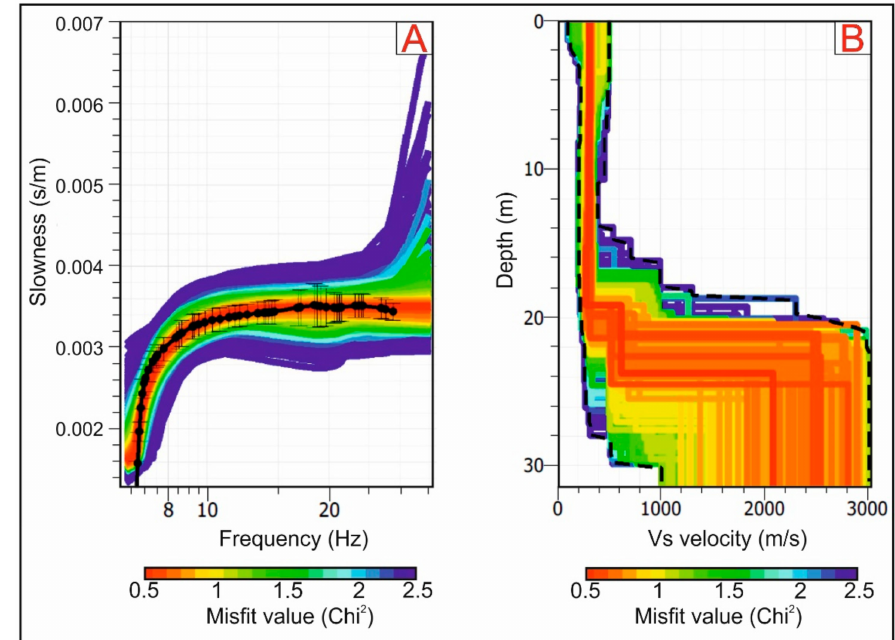
Figure 3. ( A ) The uncertainty of the dispersion curve modeling. The picked dispersion curve (black line) with the uncertainty of picking was well fitted to the synthetic models (colored areas). The chi-squared parameter for the best theoretical curves was less than one; ( B ) 1D result of the multi-channel analysis of surface waves (MASW) analysis for shot 164. The 1D velocity model presented a uniform structure up to 18 metres. Below that depth, an increase of shear velocity (Vs) was visible. Interpretation of the deeper parts was impossible, due to the penetration range of the